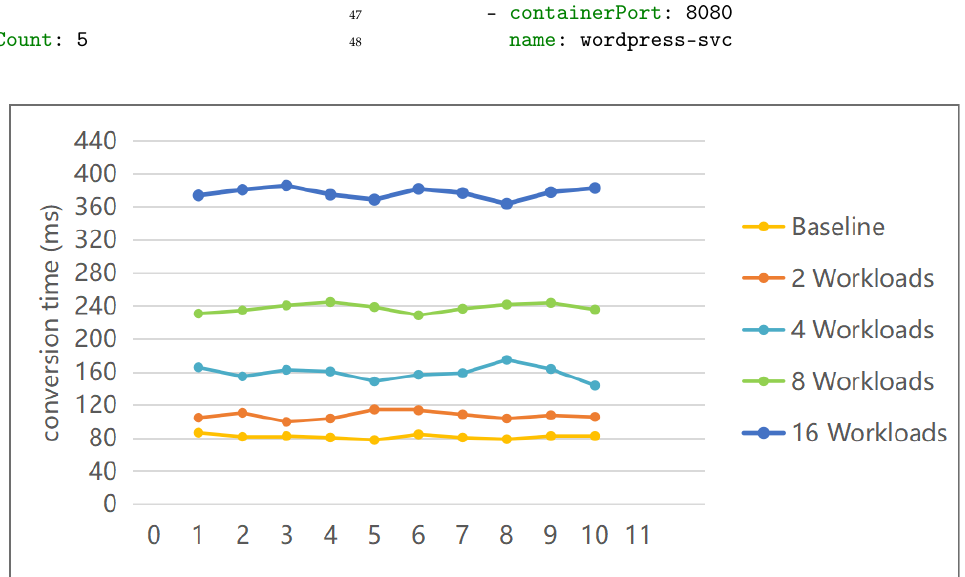
Figure 10. Conversion times of TOSCA to OAM